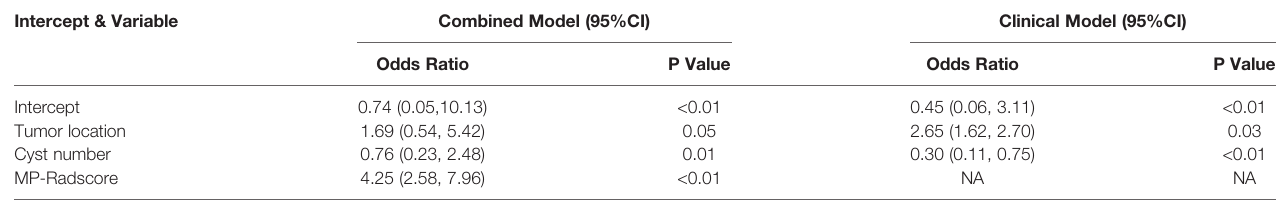
TABLE 2 | Variables Elected for Combined Model and Clinical Model.